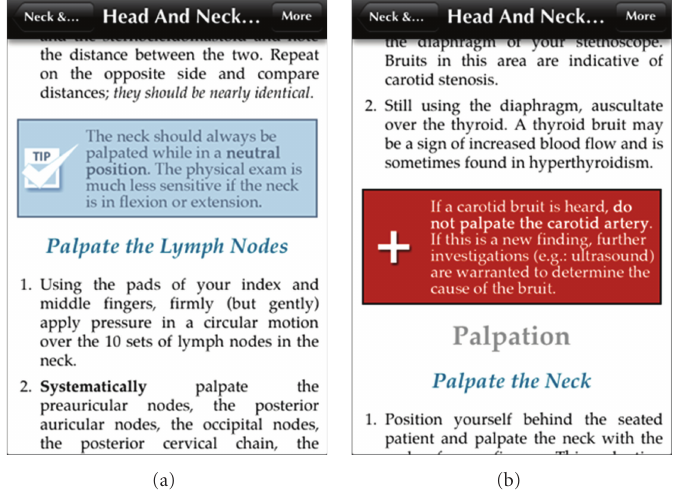
Figure 7: Tip boxes (a) And emergency boxes (b) Stand out from the text and highlight important clinical